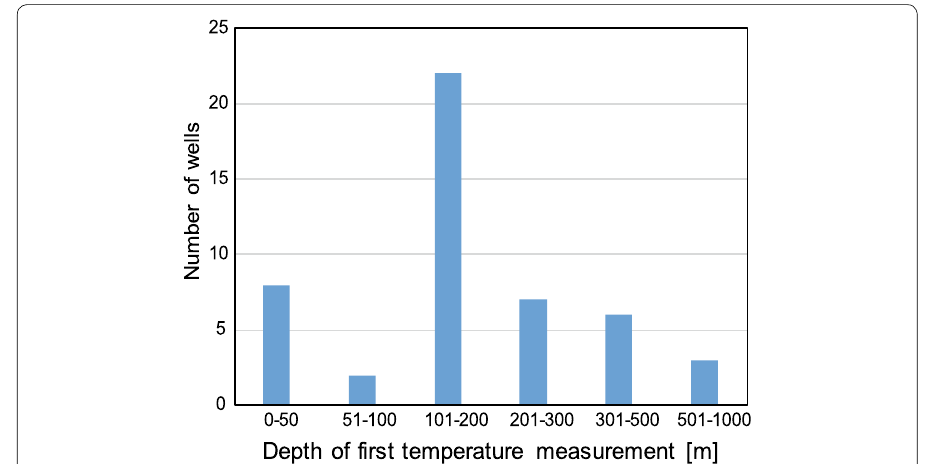
Fig. 3 Depth of first temperature measurement. The number of wells for which the first temperature measurement was made at a given depth